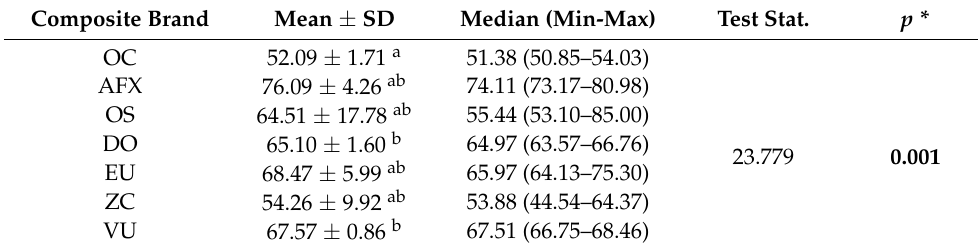
Table 3. Comparison of DC% values by composite